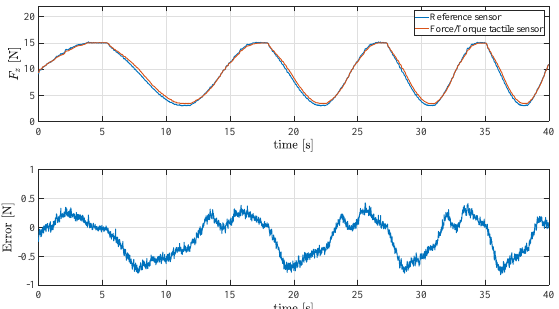
Figure 15. First experiment: Assessment of the reconstruction of the normal force